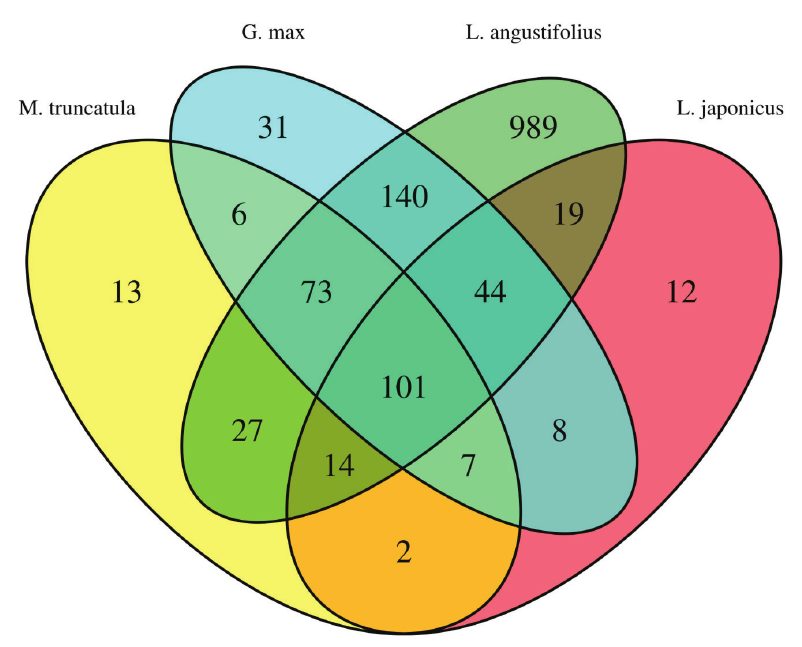
Figure 6. Numbers of DArTseq markers located in common CDS sequences between Lupinus angustifolius and three other model legume species ( Glycine max , Lotus japonicus and Medicago truncatula